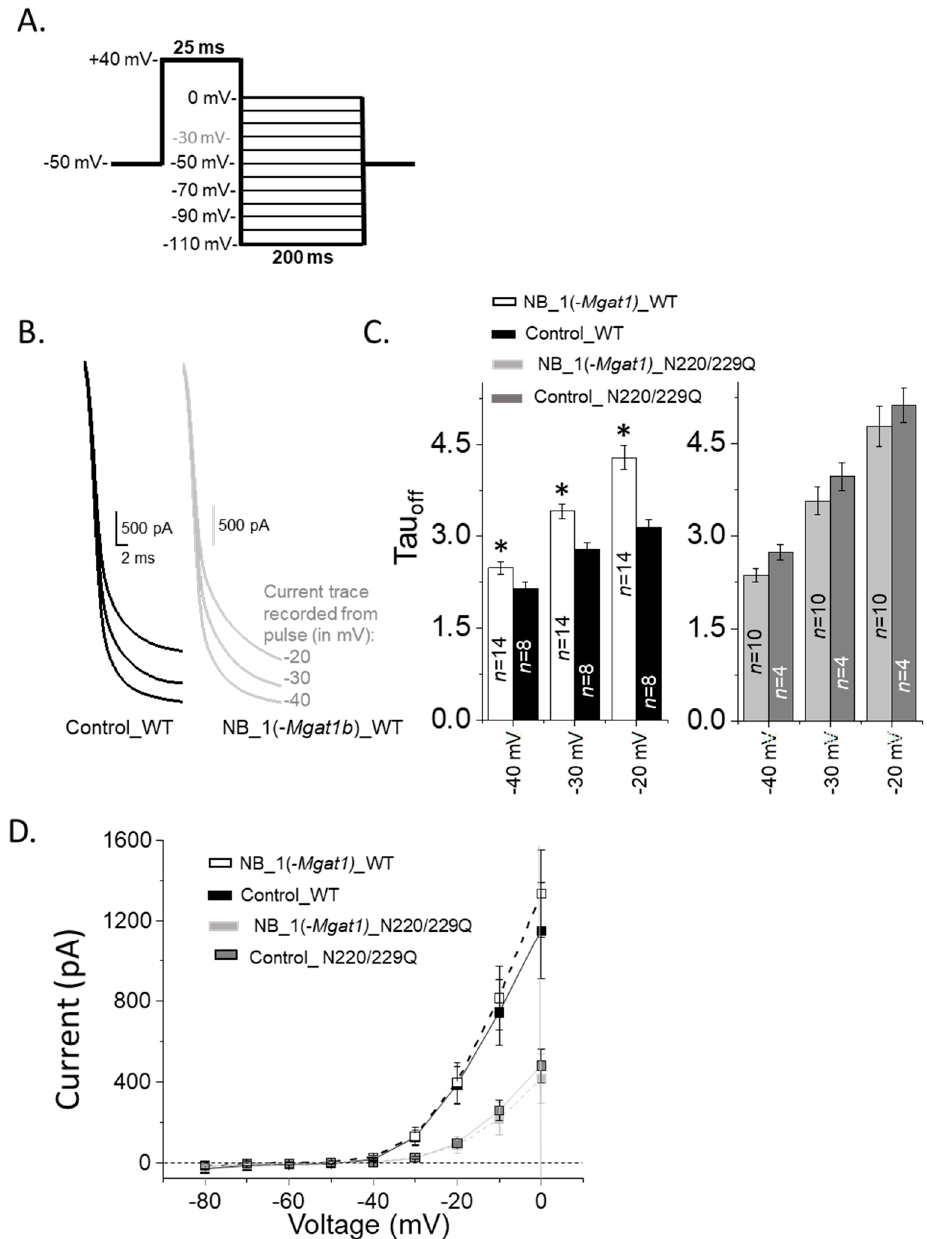
Figure 8. Closing rate of outward ionic current decreased as N-Glycan branching is lessened. ( A ) A deactivation protocol ( left panel ) was used to elicit whole currents ( right panel ) in NB cells stably expressing various forms of the Kv3.1b protein. ( B ) Expansion of deactivation currents at − 40, − 30 and − 20 mV for glycosylated Kv3.1b expressed in parental (Control_WT) and glycosylated mutant (NB_1( -Mgat1 )_WT) cells. ( C ) Deactivation time constants (Tau off ) of deactivation currents from WT Kv3.1 (left panel) and N220/229Q (right panel) expressing cell lines. ( D ) Current–voltage curves were obtained from the tail currents of the deactivation protocol for glycosylated (WT) and unglycosylated (N220/229Q) Kv3.1 α -subunits expressed in NB_1 and NB_1(- Mgat1 ). Data are presented as the mean ± SEM and were compared by Student’s t -test (* p <